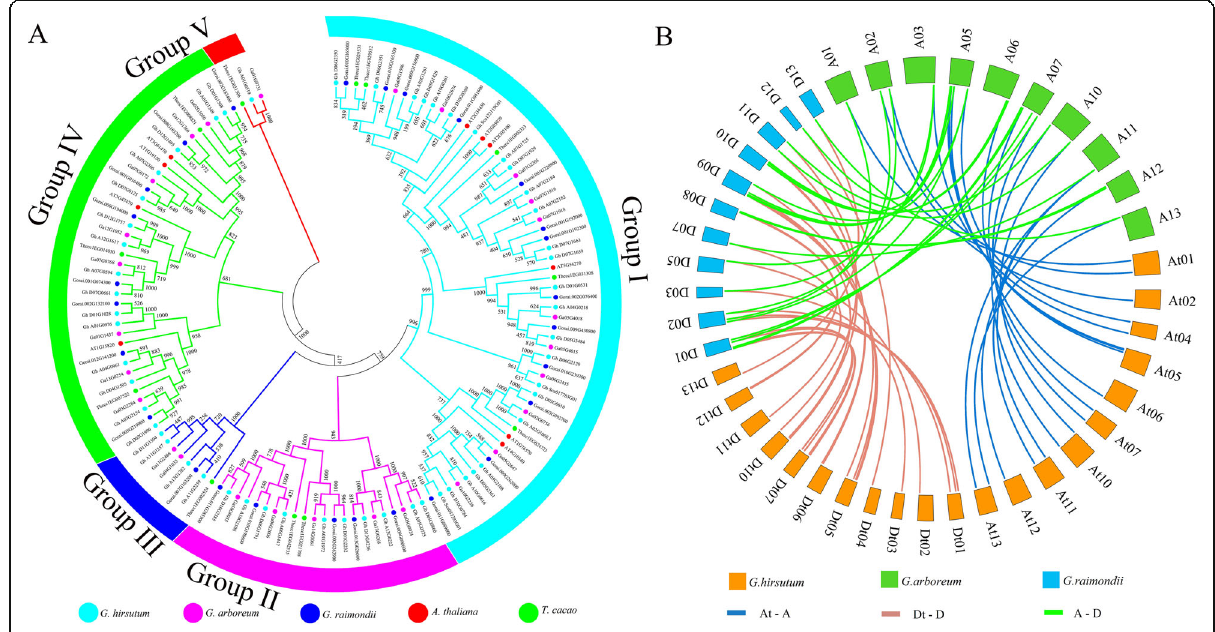
Fig. 1 a Phylogenetic tree of LHC genes in G. hirsutum , G. arboreum , G. raimondii , Arabidopsis thaliana and Theobroma cacao . The tree was done using MEGA 7.0. b Synteny blocks formation among cotton species chromosomes. A: Chromosomes of G. arboreum ; D: Chromosomes of G. raimondii , At and Dt: Chromosomes of A and D Subgenome of the tetraploid cotton, G.